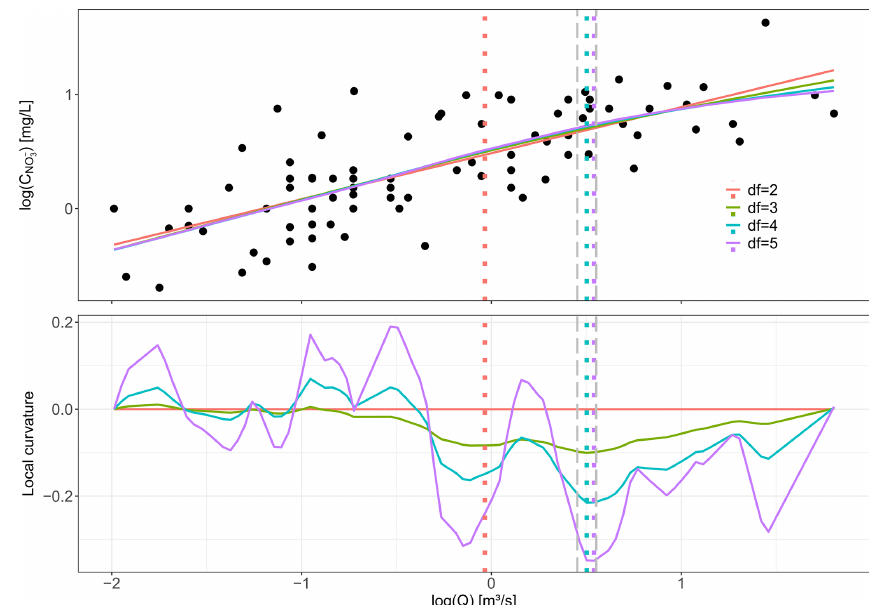
Figure B1. Conceptual figure explaining Curv max . The upper panel shows the log (C) –log (Q) relationship for Selke Meisdorf with the smoothed spline fits to these data for different degrees of freedom (df). The corresponding colors in the lower plot show then the local curvature values for these fitted smoothed splines. Also the log (Q) is indicated, for which the largest local curvature was found for each of the smoothed splines. Curv max is then calculated as the largest local curvature value for a degree of freedom of 5 in this specific case as it is the largest degree of freedom that has the largest local curvature within Q m ± 0 . 05, with Q m equal to the log (Q) of the largest local curvature for df = 3. Note that when Curv max < 0, the curve is concave, while for Curv max > 0 the curve is convex.